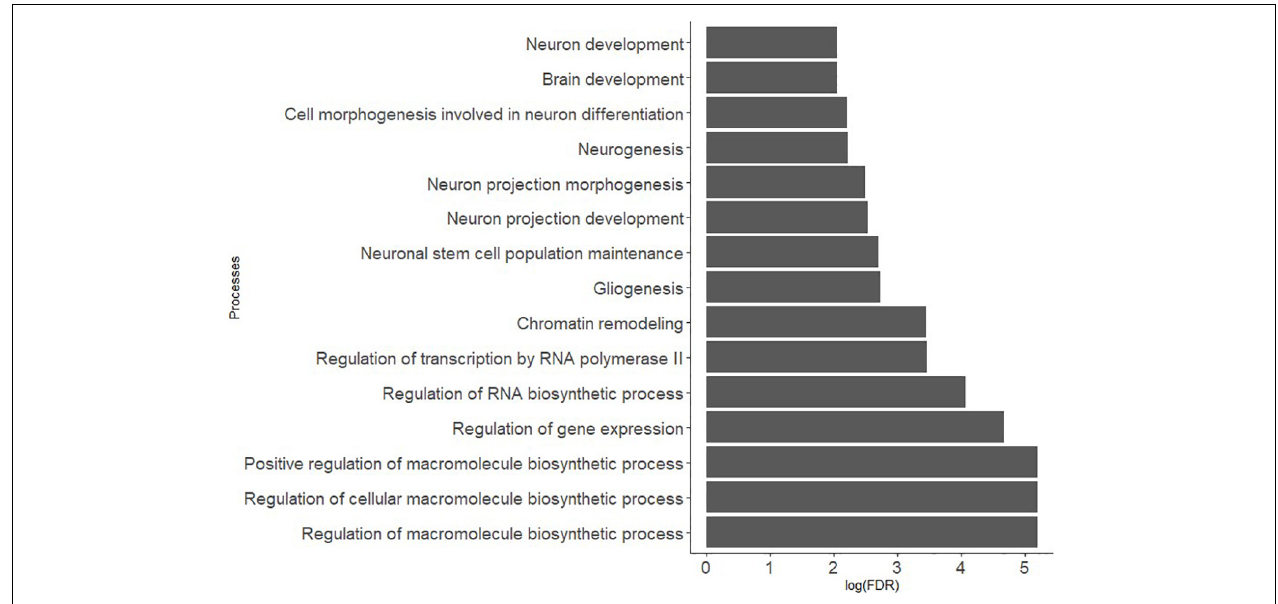
FIGURE 1 | Gene ontology processes related to the genes included in the co-expression PFC BDNF